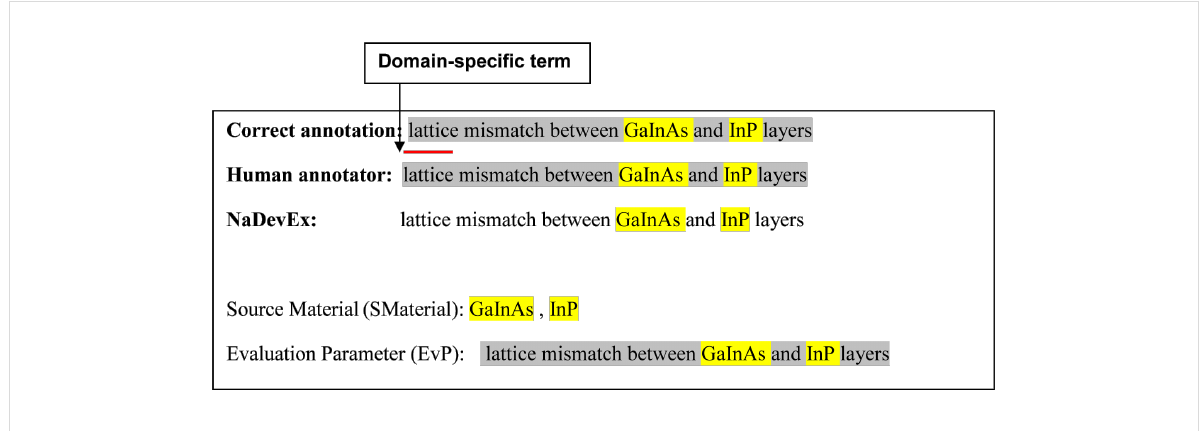
Figure 5: Domain-specific terms in NaDev